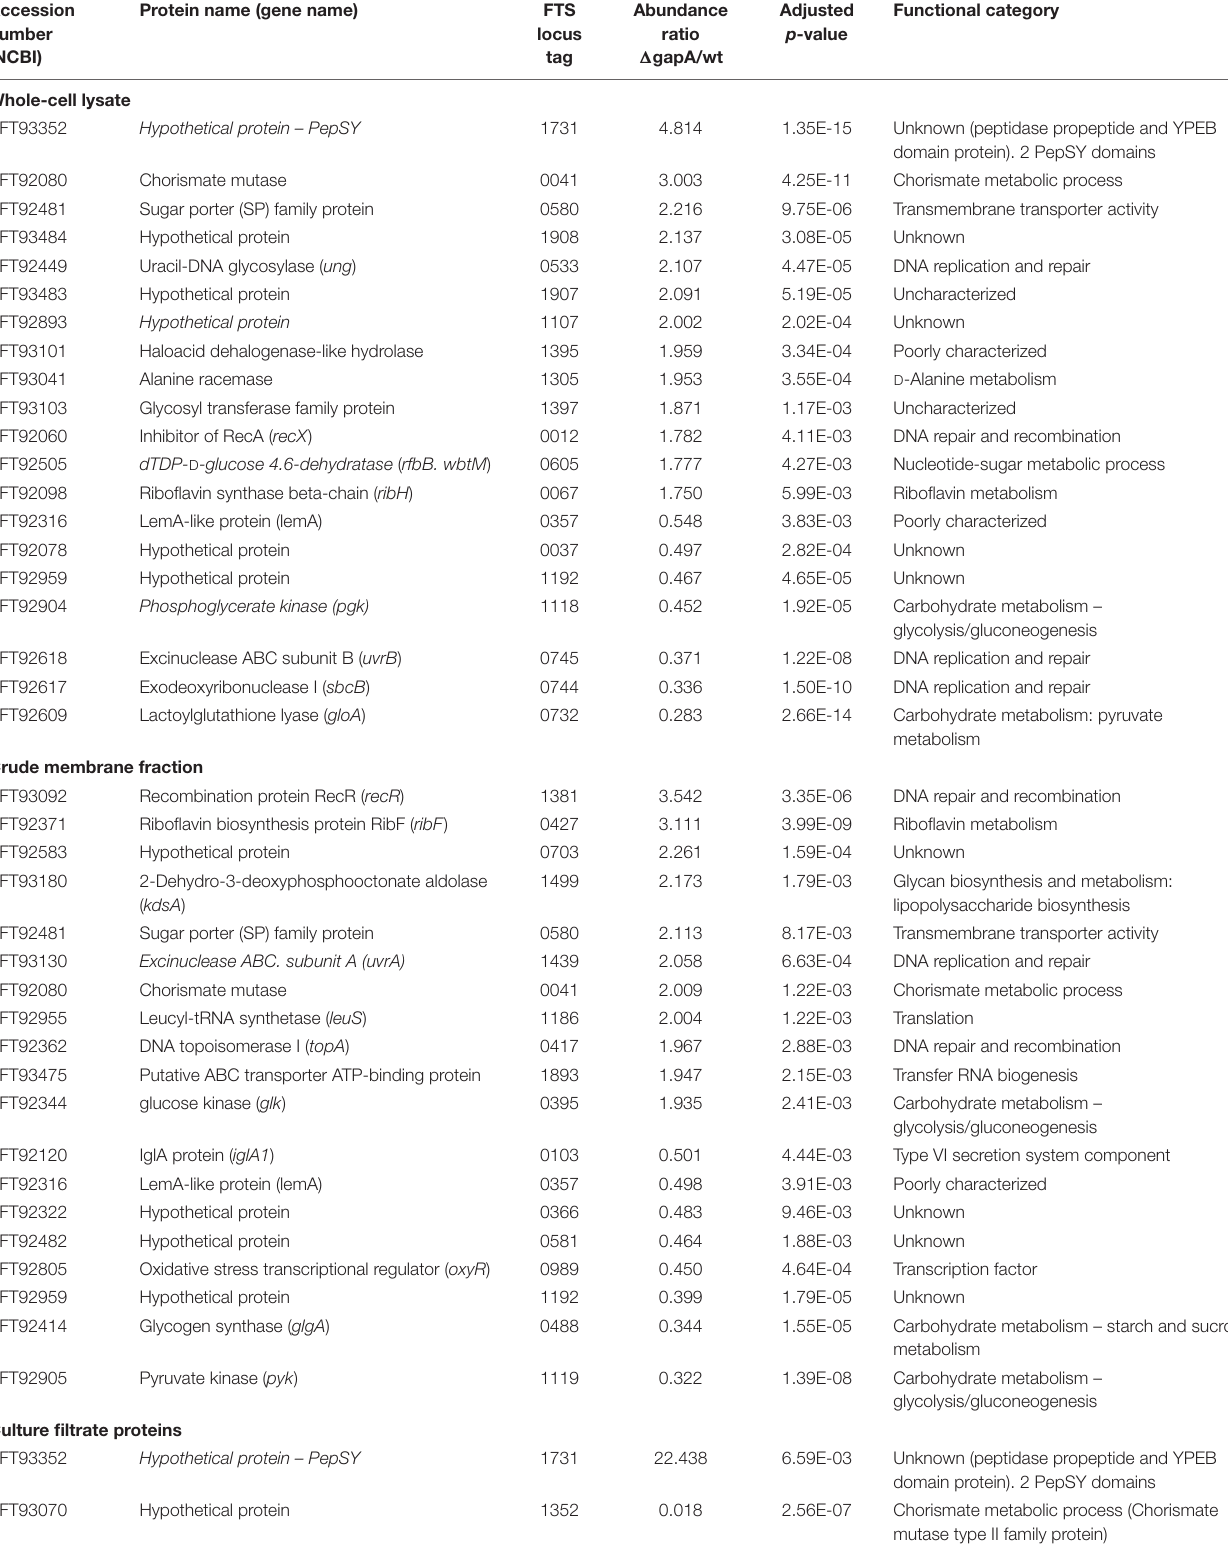
TABLE 2 | Proteins with significantly altered expression in (cid:49) gapA compared to the FSC200 wt strain detected by label-free quantitative shotgun